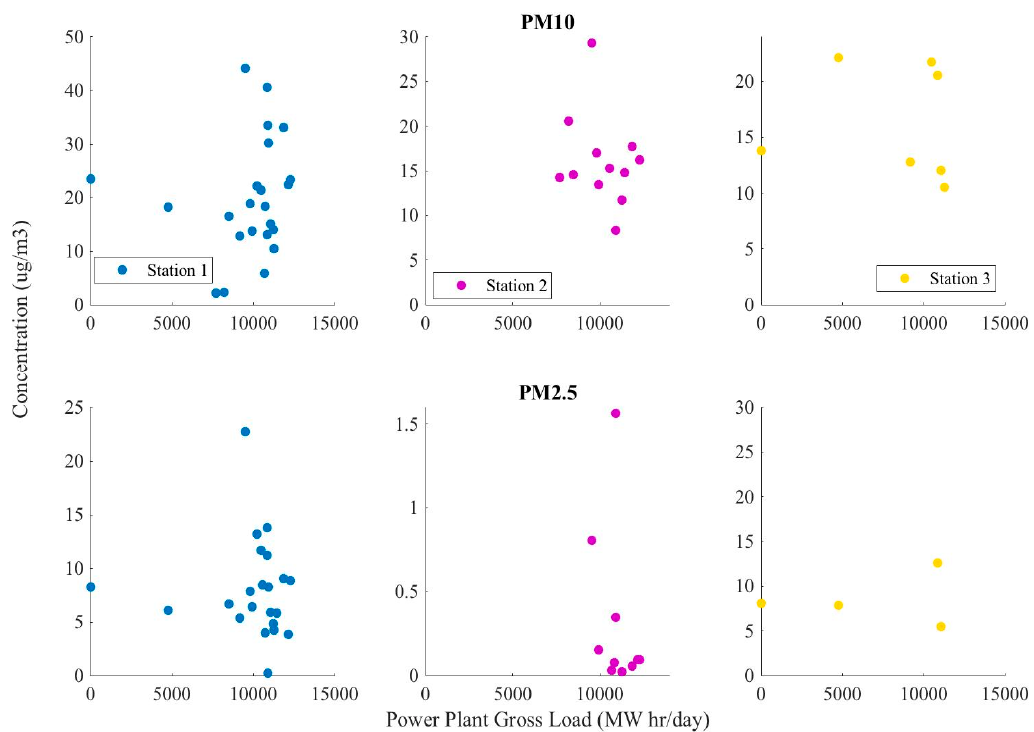
Figure 8. Comparing concentrations of PM 10 and PM 2.5 at each station with the power plant gross load. The blue dots represent the concentrations at Station 1, the magenta dots represent the concentrations at Station 2 and the yellow/gold dots represent the concentrations at Station 3.